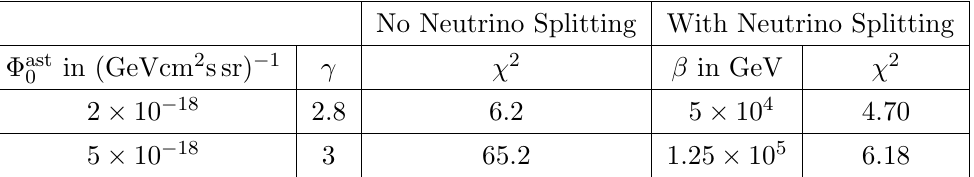
Table 1 . E(cid:11)ects of visible splitting (and the absence of it) of active astrophysical neutrinos on (cid:31) 2 in the